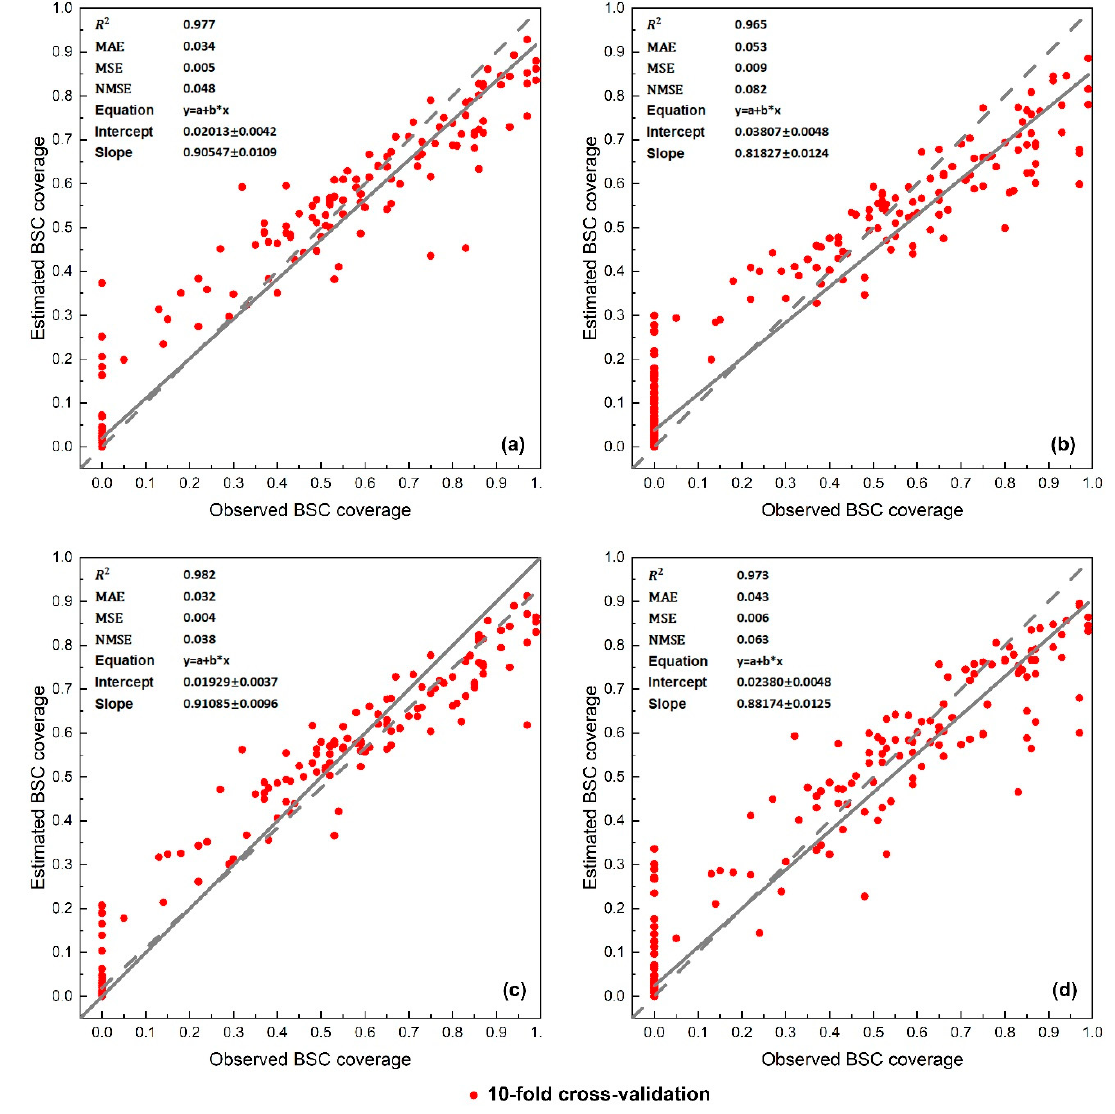
Figure 7. Plots of estimated coverage versus measured coverage of BSCs on hoop scale by: ( a ) Landsat data with band combinations based on CI; ( b ) Landsat data with band combinations based on BSCI; ( c ) Sentinel data with band combinations based on CI; ( d ) Sentinel data with band combinations based on BSCI. Solid line plot function is y = x. Dashed lines are linear fittings of predicted BSC coverage. Red dots represent results from 10-fold cross-validation of models.